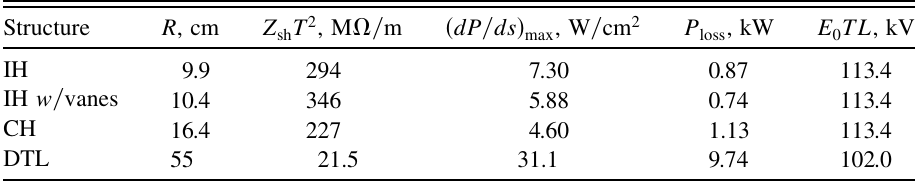
TABLE II. Structure comparison at (cid:1) ¼ 0 : 034